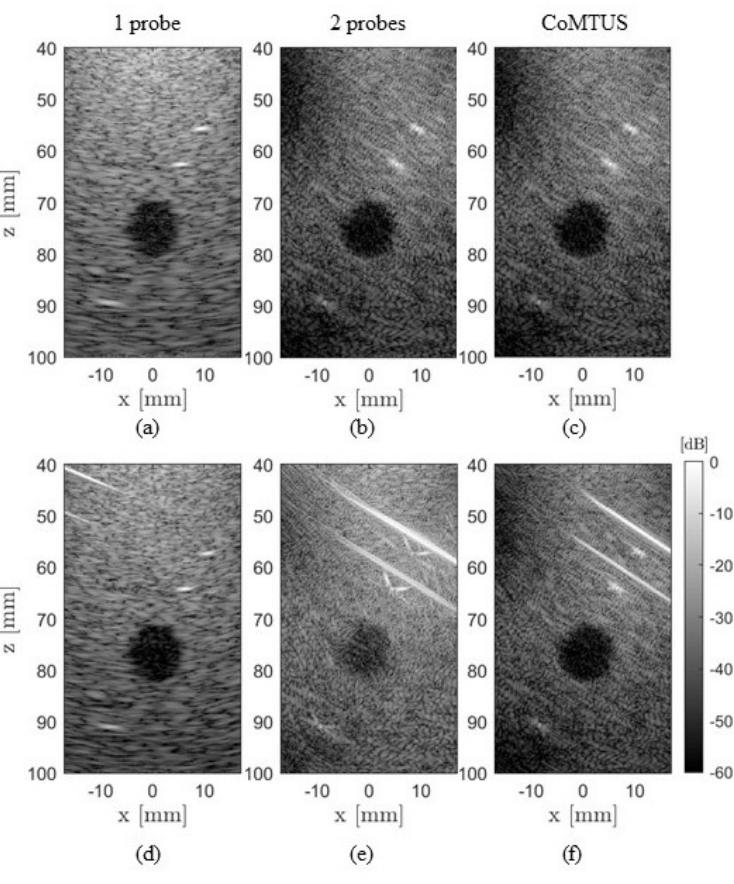
Figure 10. Comparison of simulated images for the control case ( a – c ) and imaging through fat and muscle layers of 35 mm and 8 mm in thickness, respectively ( d – f ). Different methods are compared: one probe, 2 probes and CoMTUS.